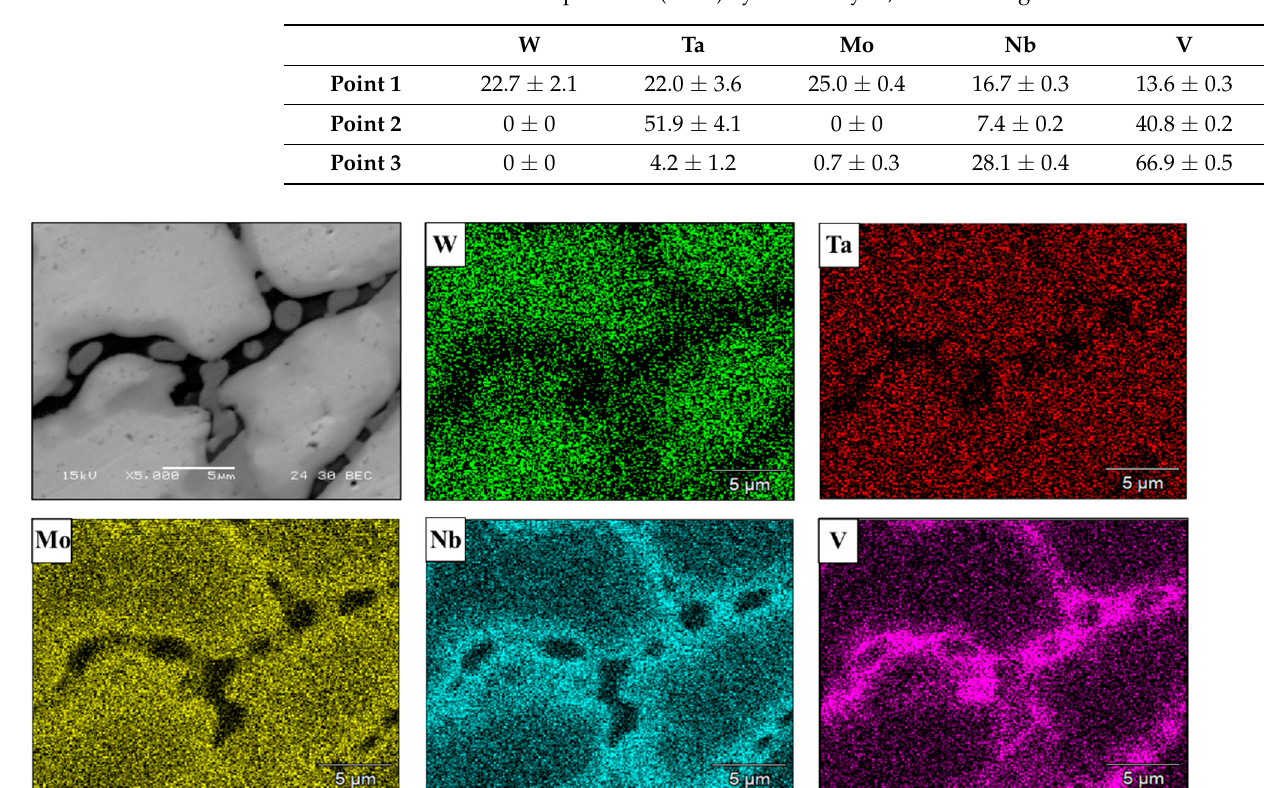
Figure 6. High-magnification image and corresponding EDS maps of elemental ingredients composing HEA WTaMoNbV alloy produced by AMF process.